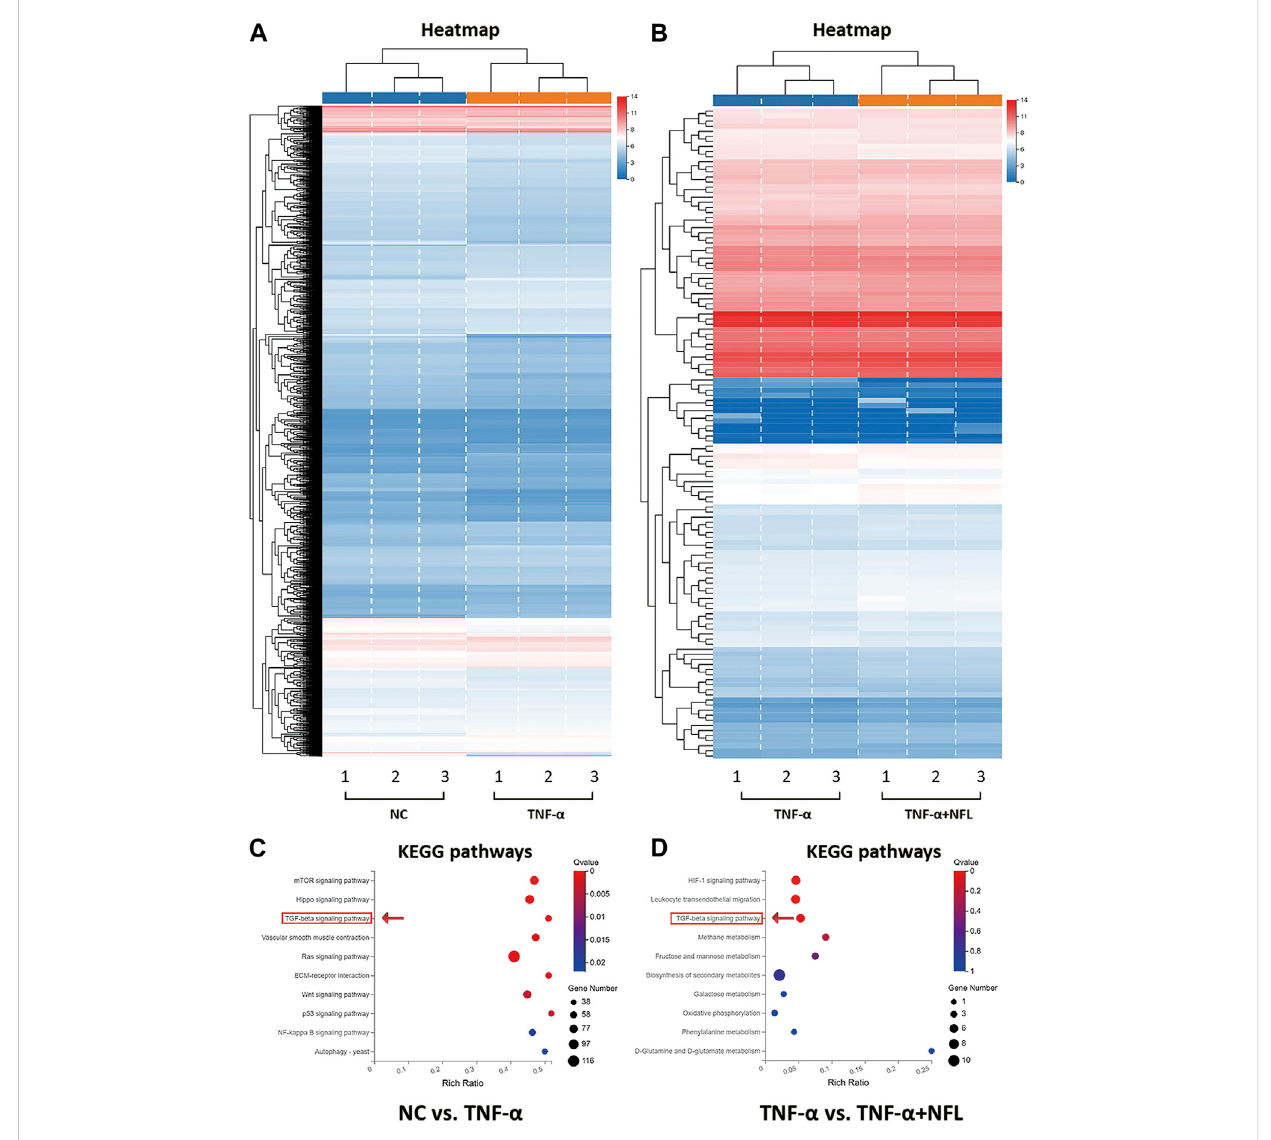
FIGURE 5 RNA-seq analysis of chondrocytes treated by NFL. (A) Heatmap of DEGs between NC and TNF- α groups; (B) Heatmap of DEGs between TNF- α and TNF- α +NFL groups. Red rectangles represent upregulation, and bluerectangles represent downregulation. Each columnof the same group indicates an independent biologicalreplicate( n = 3); (C) KEGGanalysisofDEGs between NCand TNF- α groups; (D) KEGG analysis ofDEGs betweenTNF- α and TNF- α +NFL groups. The color key from blue to red represents the q value from high to low and the size of the bubble indicates the gene